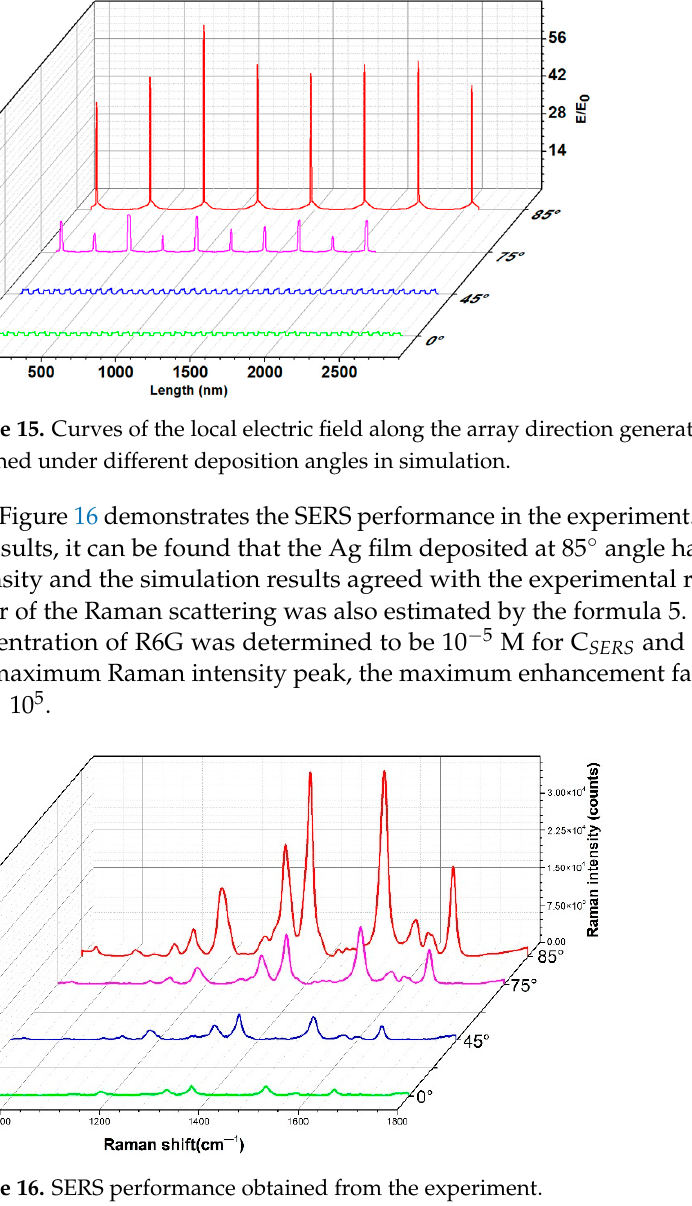
13 of 16 Figure 14. Electric field distribution diagram of Ag film obtained from different deposition angles. The curves in Figure 15 show the local enhanced electric field intensity of nanostruc- ture film obtained under different deposition angles in simulation. From the figure, when the deposition angles were 0° and 45°, the intensity of the local enhanced electric field was about 3 to 5 times compared to the incident electric field. However, when the deposition angles were 75° and 85°, the intensity was 18 times and 69 times compared to the incident electric field. According to the contribution of the electromagnetic field in Raman scatter-